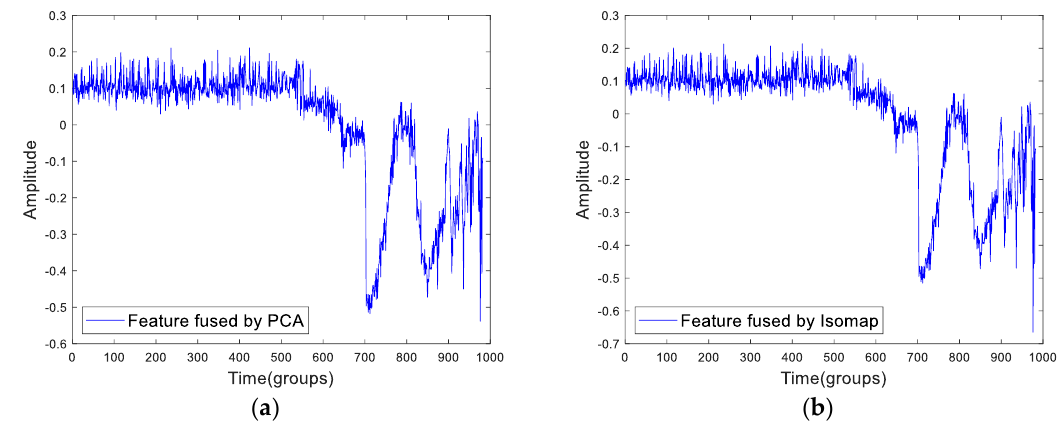
Figure 20. The fused feature of RMS 2 and SampEn based on ( a ) principal component analysis (PCA) and ( b ) Isometric Feature Mapping (Isomap).